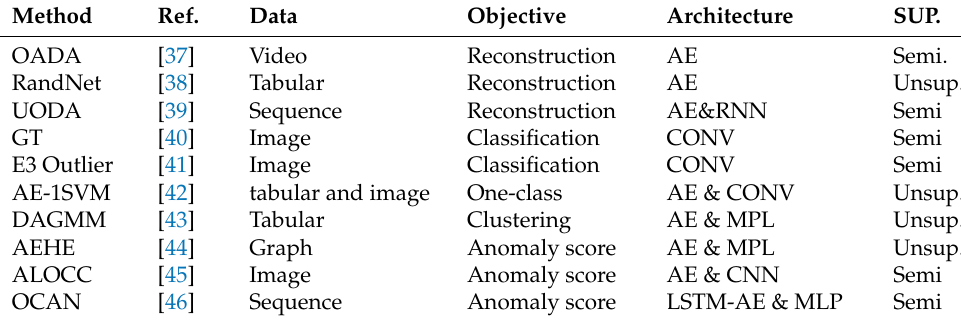
Table 1. DL-based anomaly detection techniques using AE or Hybrid